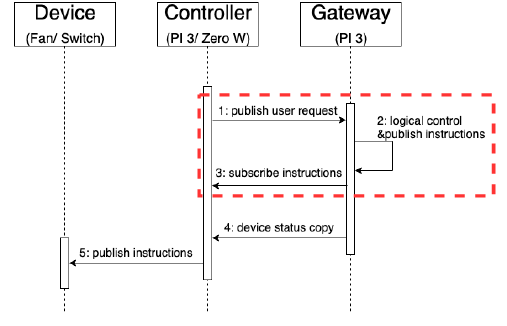
Figure 14. Timing sequence diagram of publish/subscribe at the same devices by logical control. This process simulated the smart-device controller (SDC) to control a smart device.